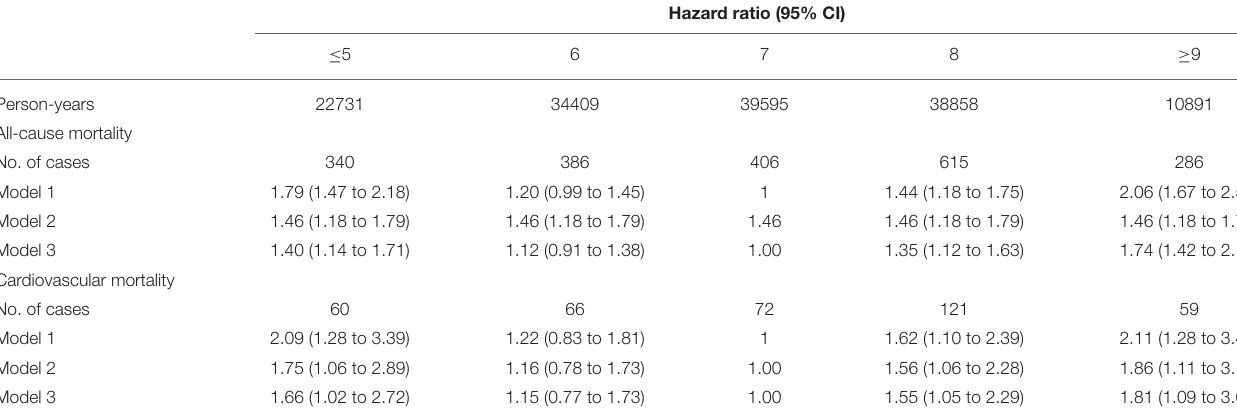
TABLE 2 | Hazard ratios (95% CIs) of all-cause and cardiovascular mortality according to sleep duration in